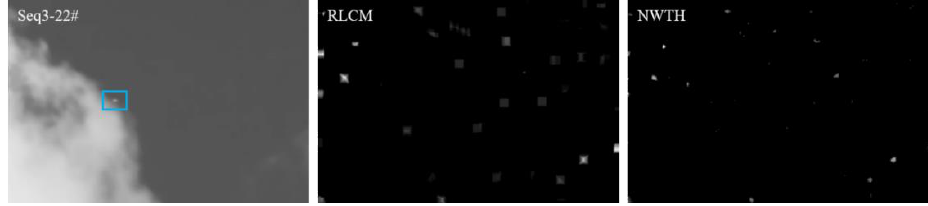
Figure 10. No target was detected by RLCM and NWTH in sequence 3 in some frames.